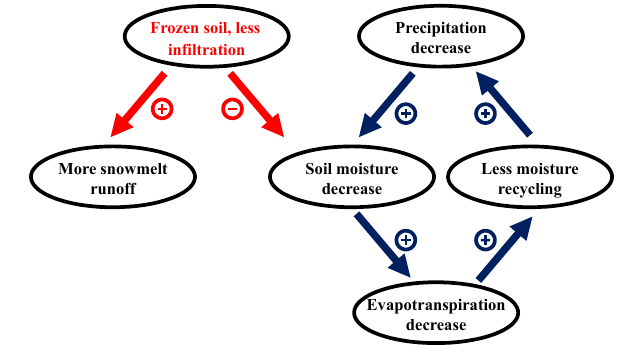
Figure 11. Chain of processes involved in the soil-moisture– precipitation feedback over high latitudes. Red arrows indicate the initiation of the positive feedback loop by the presence of frozen soil; blue arrows indicate the loop itself.